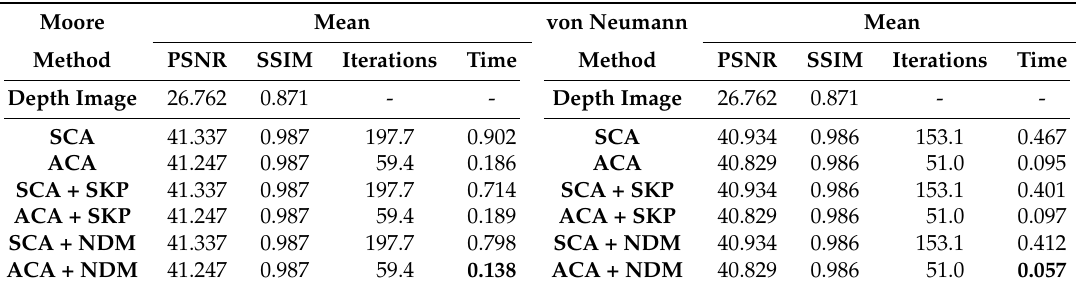
Table 6. Quantitative evaluation results for comparing internal algorithms of the proposed method on the entire Tsukuba Stereo Dataset. Left and right tables show the results using the Moore and von Neumann systems, respectively. The best computation times are highlighted in bold.